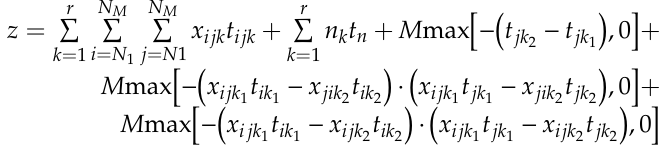
Figure 3. Chromosome A.